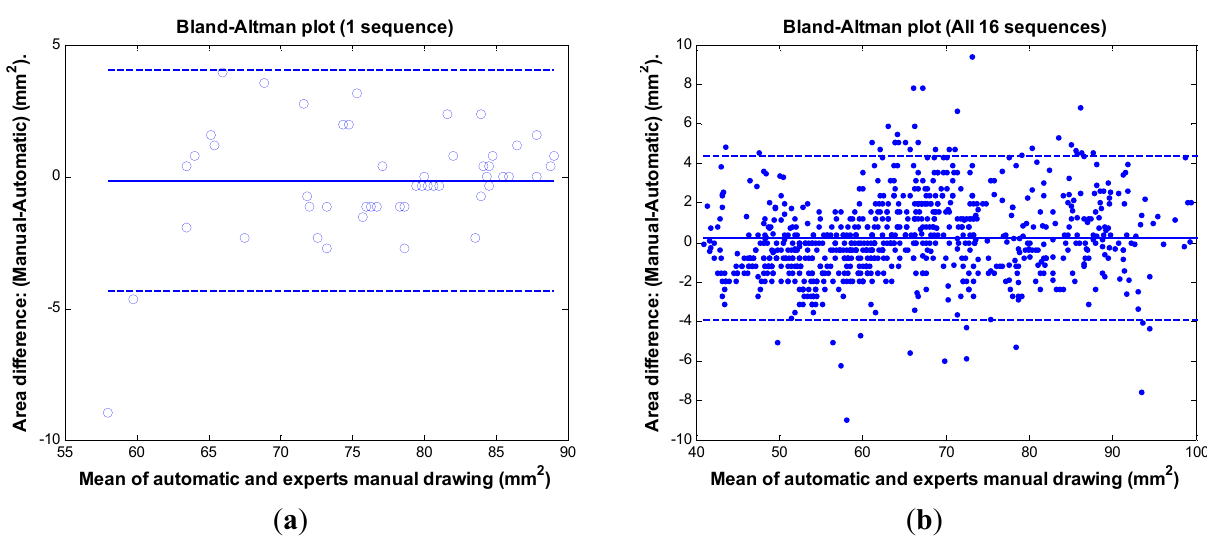
Figure 10. Bland-Altman plots. The solid line indicates the mean, and dash lines are ± 1.96 SD. ( a ) The plot of sequence no. 9 (50 images). (1.96 SD = 4.2 mm 2 ); ( b ) The plot of all 16 sequences (800 images). (1.96 SD = 4.1 mm 2 ).